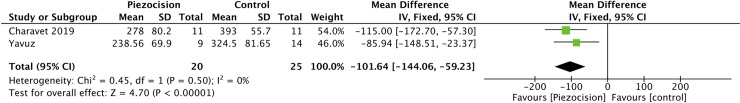
Forest plot demonstrating piezocision effects on overall treatment duration by months.